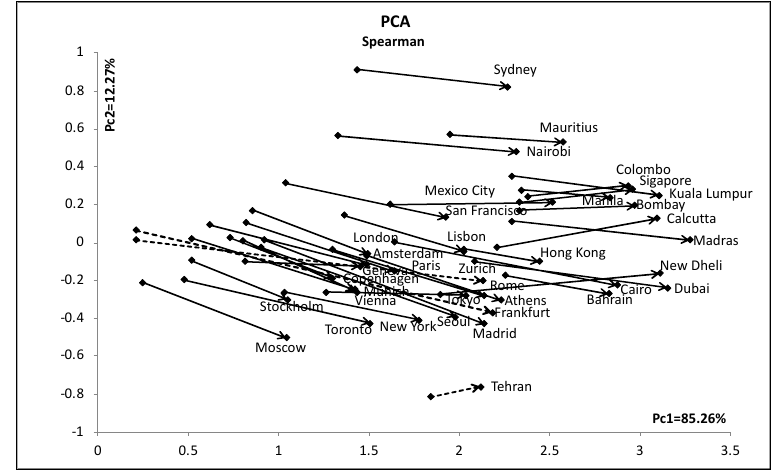
Figure 13. PCA result for city temperature data.